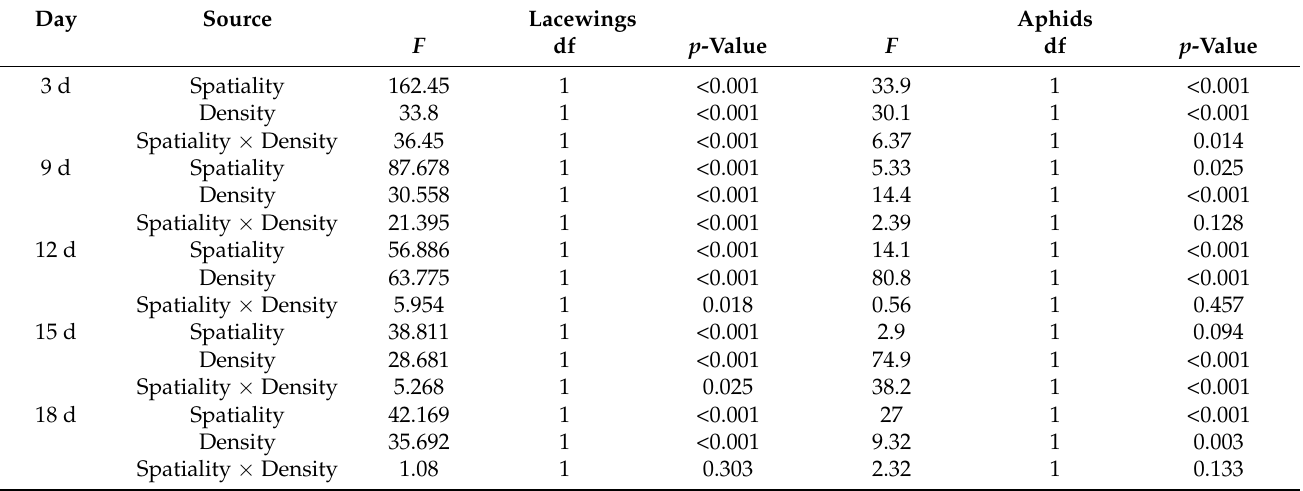
Figure 5. The colonization rate of Chrysopa pallens in greenhouse-grown eggplant crops with different spatial arrangements and densities of Ocimum basilicum . The colonization rate refers to the retention rate of the lacewings that were initially released at the start date. The bar charts show mean ± SE values. Different letters above a given bar reveal statistically significant differences between treatments ( p < 0.05). Table 1. ANOVA of the effects of the density, spatiality, and their interactions on the abundance of lacewings Chrysopa pallens and aphids Myzus persicae in different spatial arrangements and densities of Ocimum